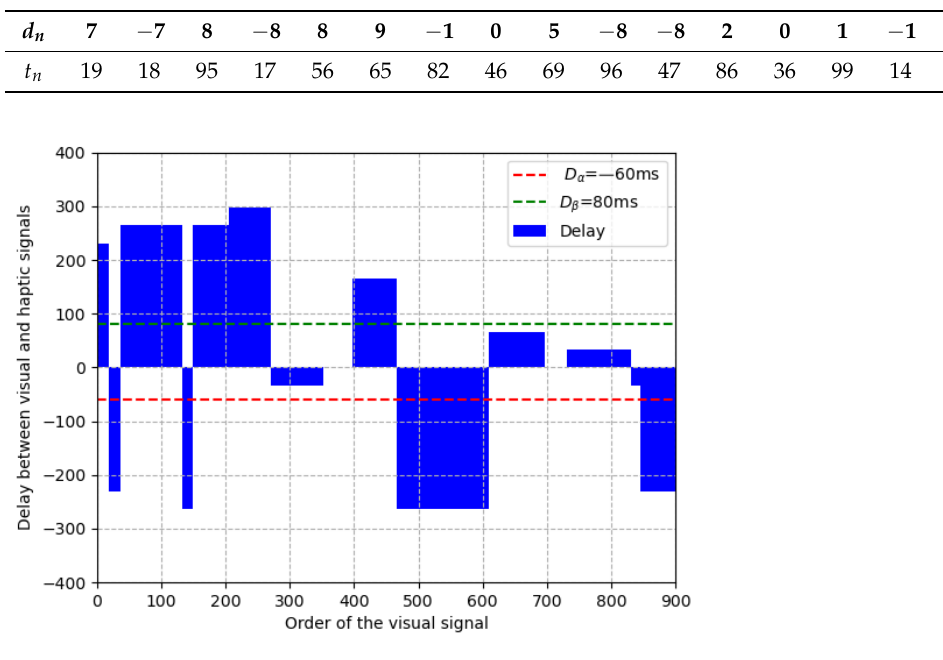
Figure 7. An example of random delay in the experiment.